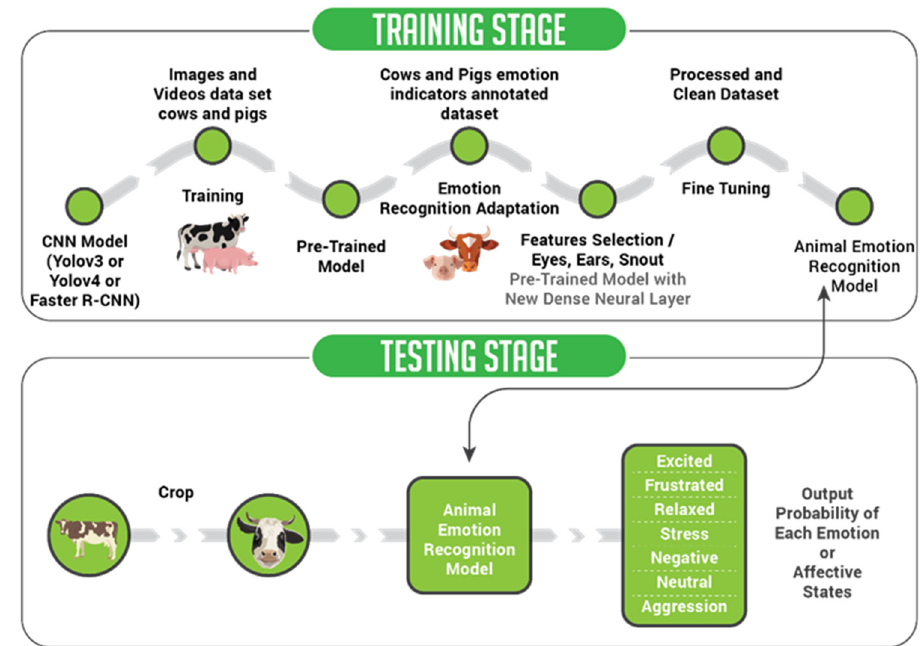
Figure 3. Illustration of the proposed WUR Wolf Facial Emotion Recognition model based on Deep Convolutional Neural Networks. The process pipeline includes feature selection and extraction, bounding box prediction, and the output of recognition of affective states.